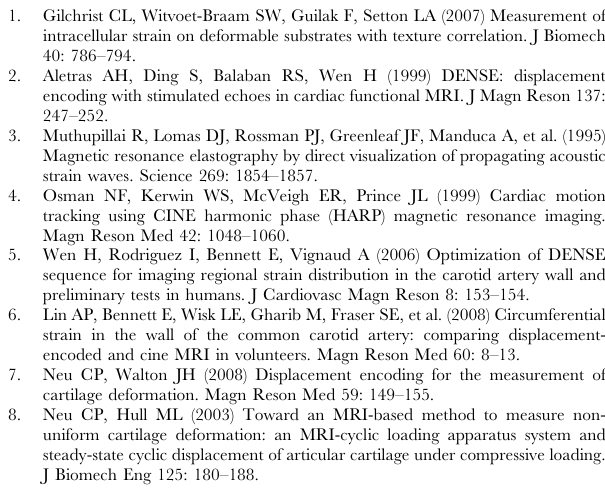
repetition time (TR), for a total of M acquired lines to fill the data space. Because of the flexibility of TrueFISP, the acquisition can be segmented (i.e., into 4 segments) so that it is completed in less time within each cycle, at the cost of more (i.e. 4 N ) imaging cycles loading regime, only one line of data per frame is acquired each TR to maximize temporal resolution during cine acquisitions ( C ). Figure S2 Standard anatomical MRI permitted regis- tration to gross anatomy. The slice from the standard multi- slice anatomical scan that corresponded to the physical location of the joint during the unloaded portion of the cyclic loading is shown ( A ). The tibiofemoral joint was opened for still photographs of the articular cartilage surface, menisci, and ligaments, before ( B ) and after ( C ) resection of the cruciate ligaments. Registration landmarks, including the distance between the tibial tubercles, the location of the origin of the popliteus tendon, and the width of the interconsylar notch, were identified on the standard anatom- ical MRI and then located within the joint, allowing for the coronal slice imaged with DENSE-FISP to be identified. The open black rectangles indicate the approximate surface areas represent- ed in the DENSE-FISP scans. Sections of the contacting regions of the femur and tibia were then detached with a reciprocating saw before a modified coring reamer was then used to remove multiple full-thickness plugs from each of the tissue sections. The open aqua circles indicate the approximate locations from which full thickness plugs were removed for